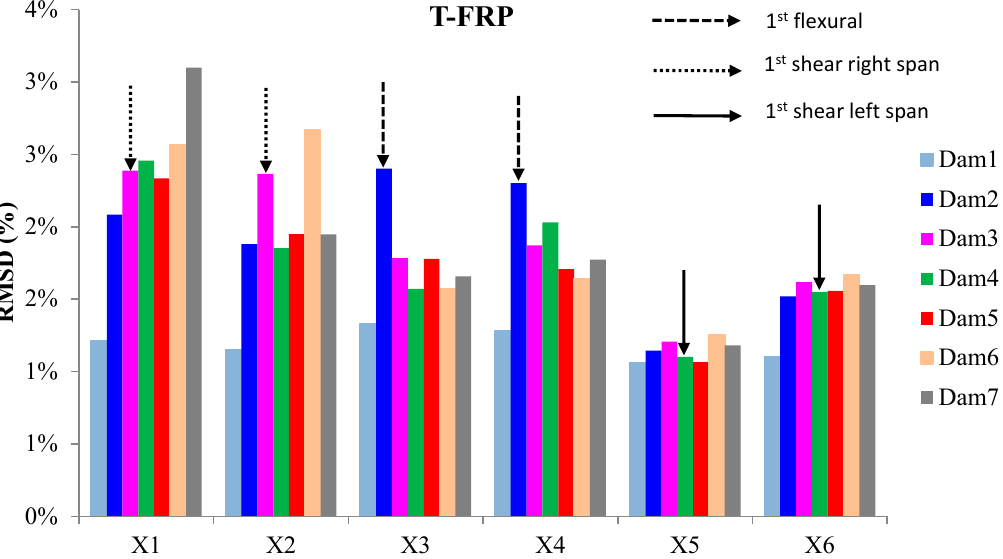
Figure 11. RMSD index values of PTZs externally epoxy-bonded on the surface of T-FRP.